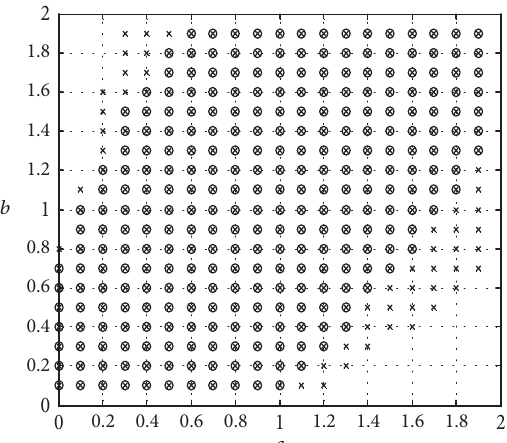
� 0 . 45 , ρ � 0 . 5 , 1 2 � 0 . 5 , ρ � 0 . 75 , and 1 2